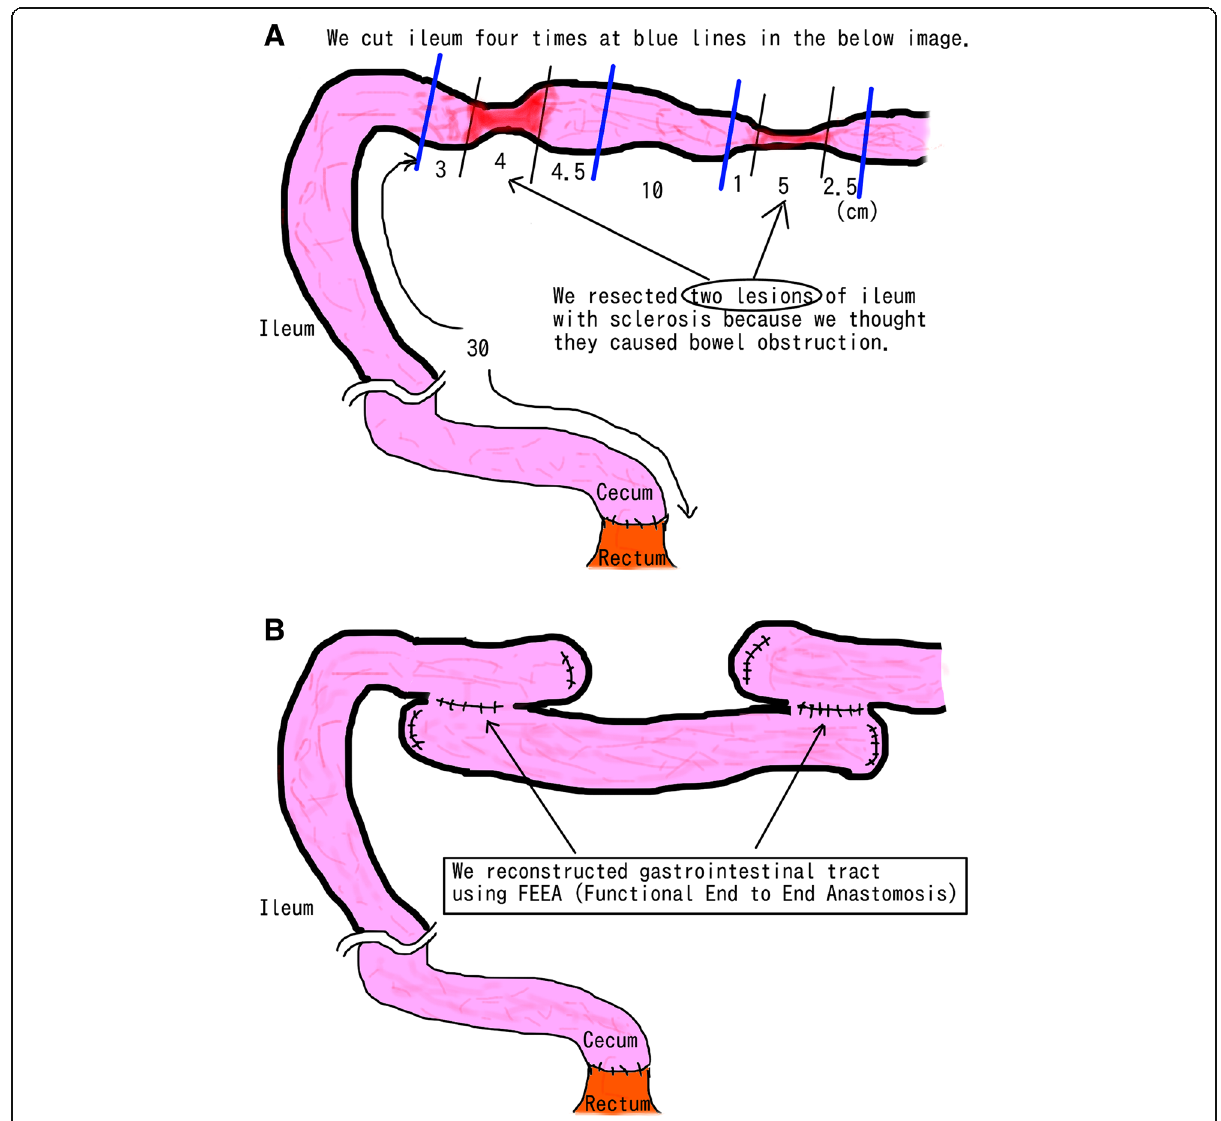
Fig. 3 The patient ’ s cecum and rectum were anastomosed due to the previous surgery (subtotal colectomy). We recognized two sections of small bowel 33 cm and 53 cm from the terminal ileum seemed to be sclerotic, with extraordinarily thick walls ( a ). We resected these two lesions and anastomosed them using FEEA (functional end-to-end anastomosis), thus obtaining two specimens ( b